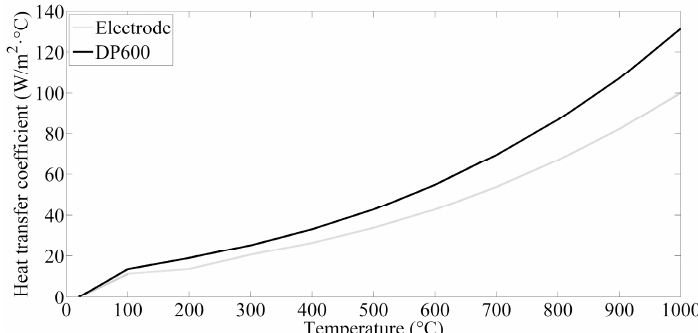
Figure 2. Surface coefficients of heat transfer of electrodes and steel.